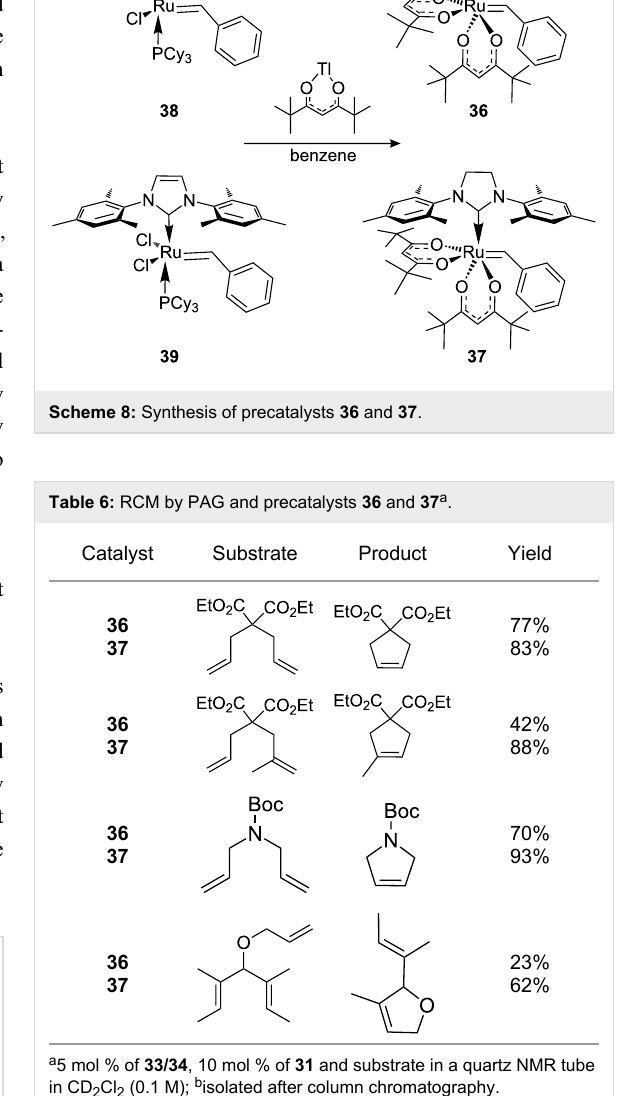
Acid sensitive complexes 36 and 37 were synthesised starting from the Grubbs type catalysts 38 and 39 and thallium hexa- methylacetylacetonate (Scheme 8). Several RCM substrates were closed as shown in Table 6 by the PAG induced metathesis. Complexes 36 or 37 and PAG 34 also polymerised typical ROMP monomers in excellent conversion (Table 7).